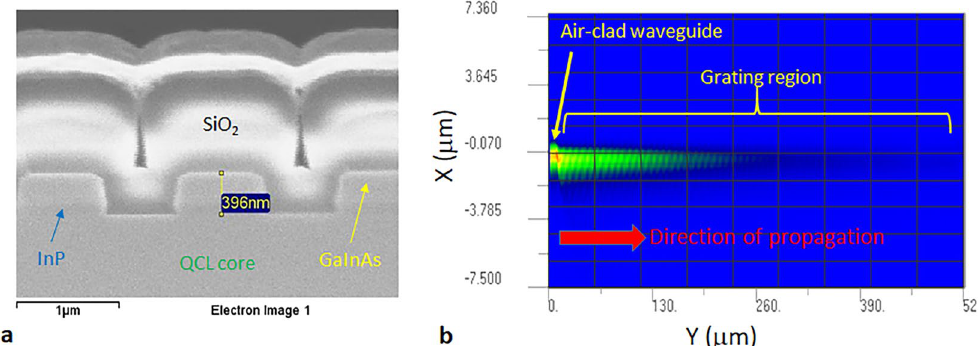
Figure 2. Grating geometry and simulation. ( a ) Cross-sectional scanning electron microscope image of grating outcoupler covered by SiO 2 . ( b ) 2D FDTD simulation of the Poynting vector in the y-direction for guided light propagating though a 500 μ m long grating